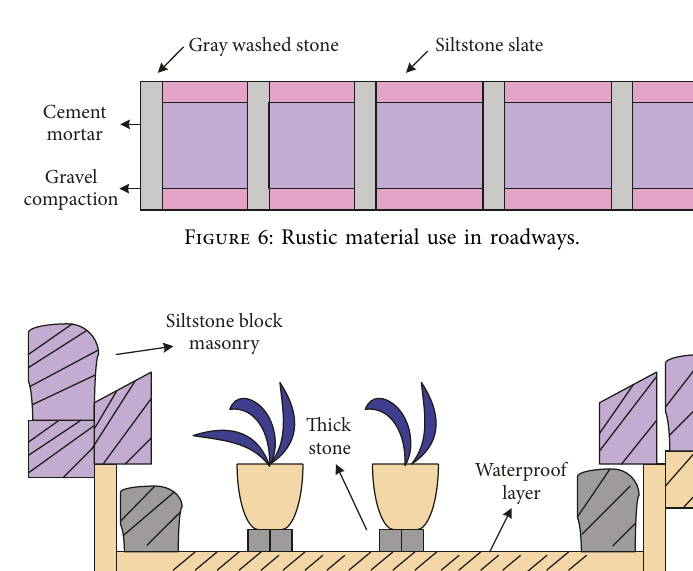
Figure 7: Rustic material plan for fire